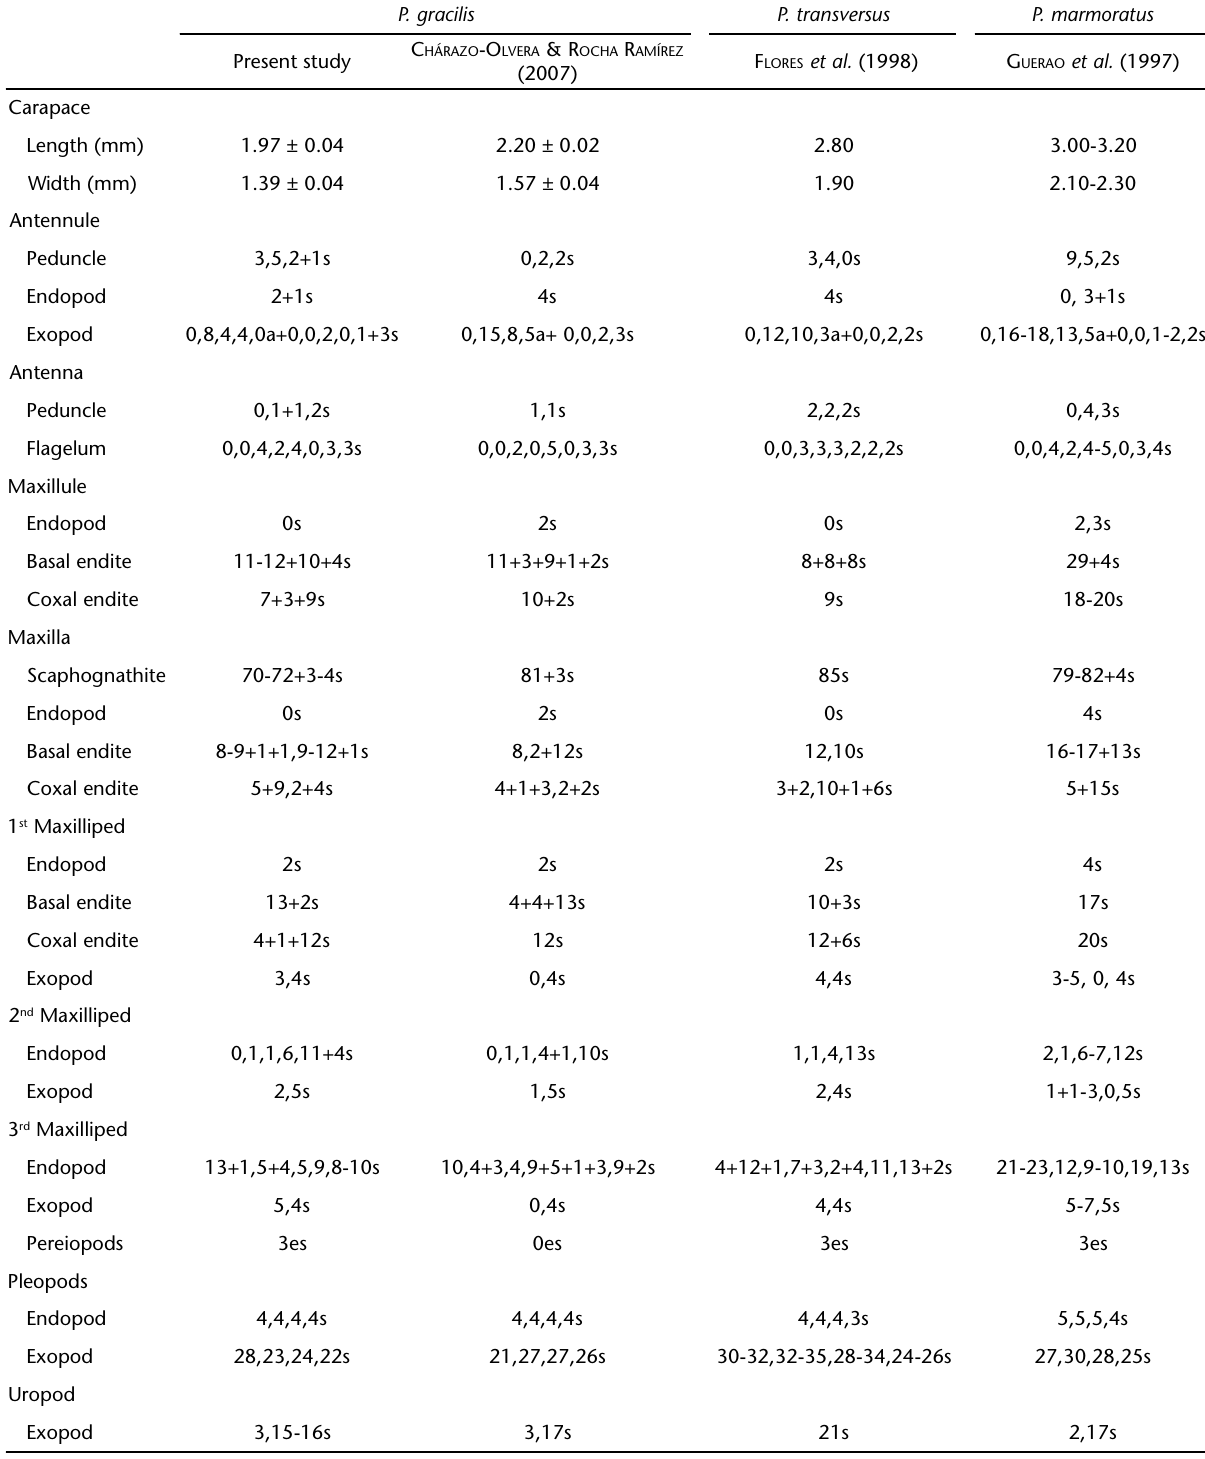
Table I. Morphological comparisons among megalopa stage of some Pachygrapsus species. (s) Setae, (a) aesthetascs, (es) elongated setae. P.